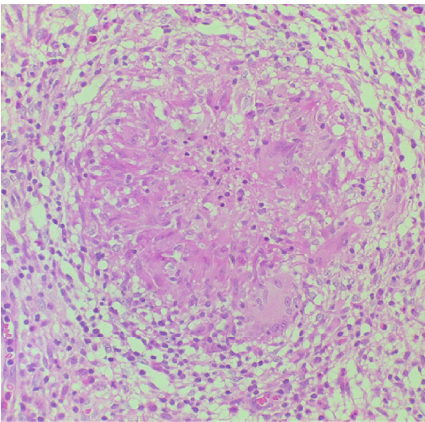
Figure 2: H + E stain of synovial biopsy showing granulomatous inflammation (400x magnification).